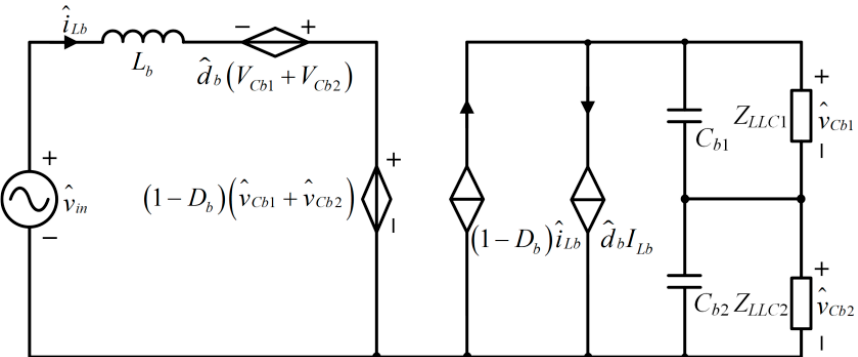
According to (1), the equivalent circuit of the small-signal model of the interleaved Boost converter can be obtained, as shown in Figure 3.